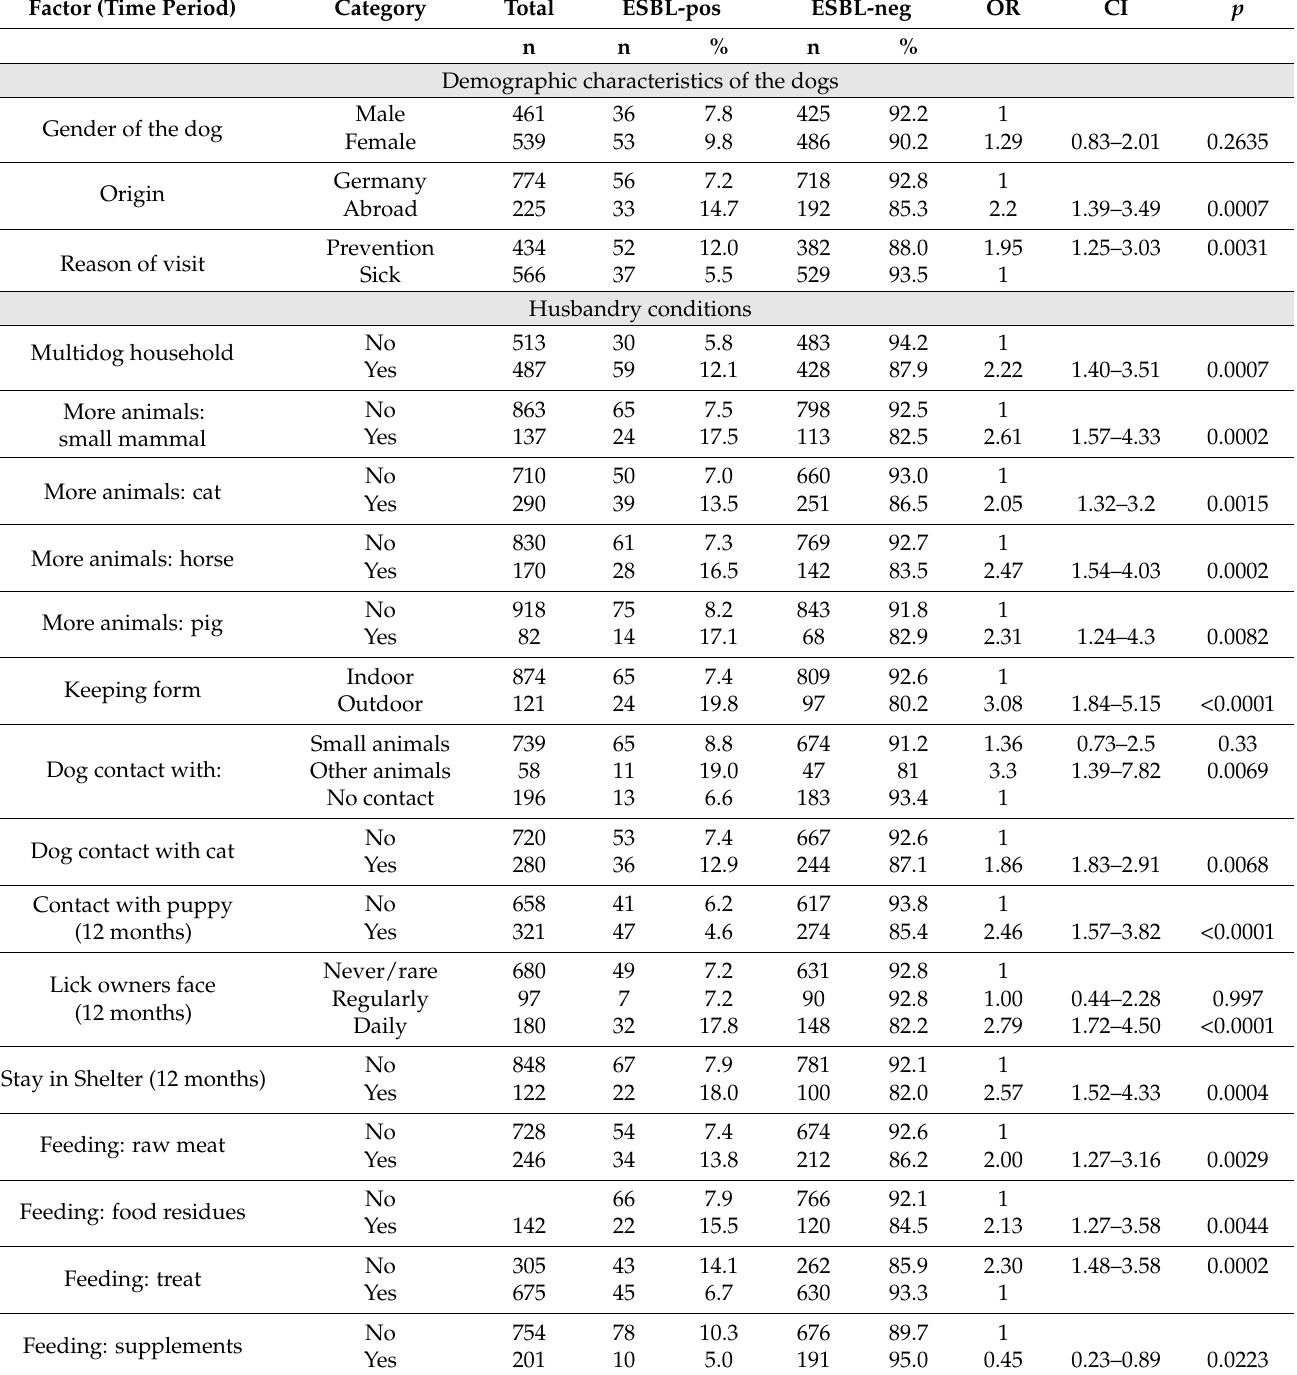
Table 1. Basic questionnaire variables * and association with ESBL carriage in the univariable model. CI = 95% confidence interval from Wald; p = p -value from linear logistic